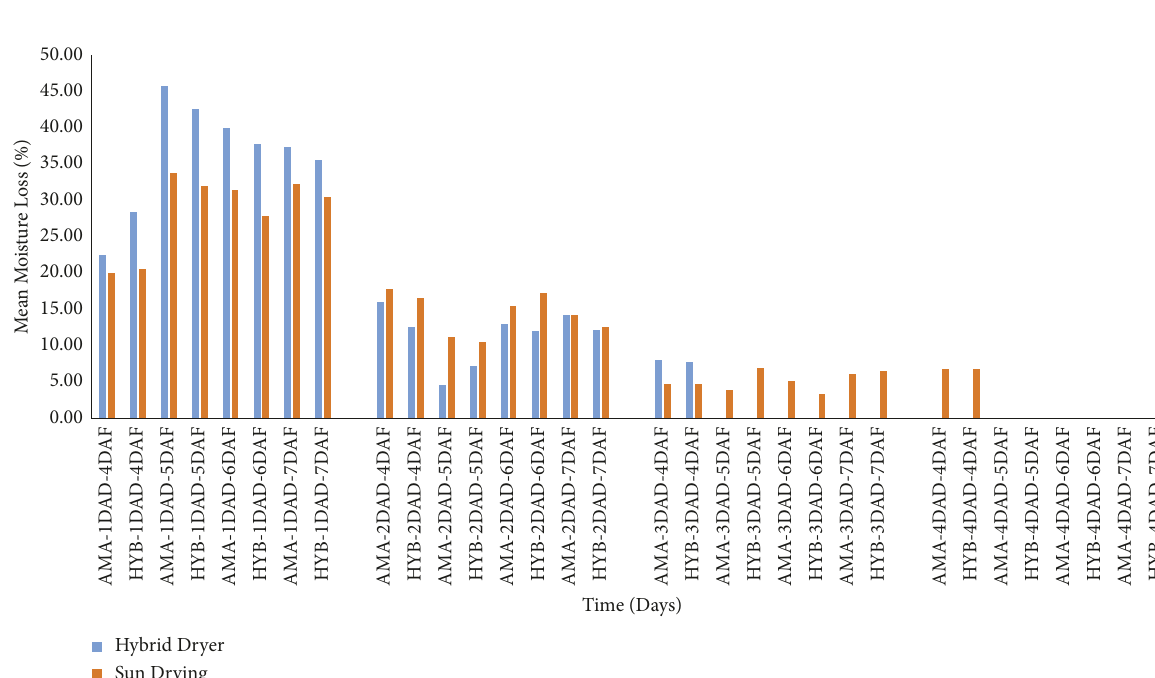
Figure 4: Mean moisture loss (%) of two cocoa varieties under different drying (4 days) and fermentation periods (7